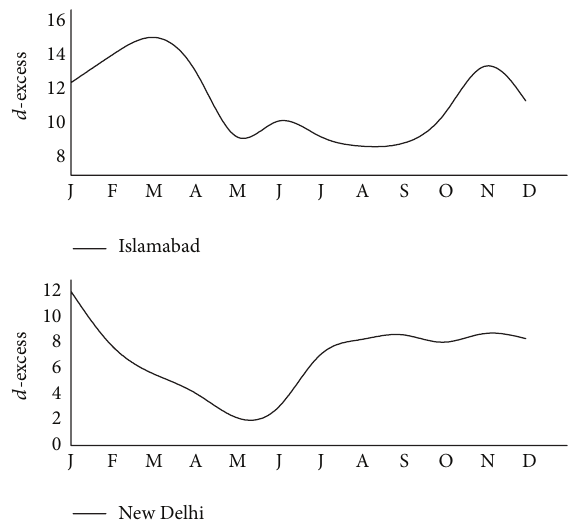
Figure 14: Comparison of weighted monthly mean of d -excess of Islamabad and New